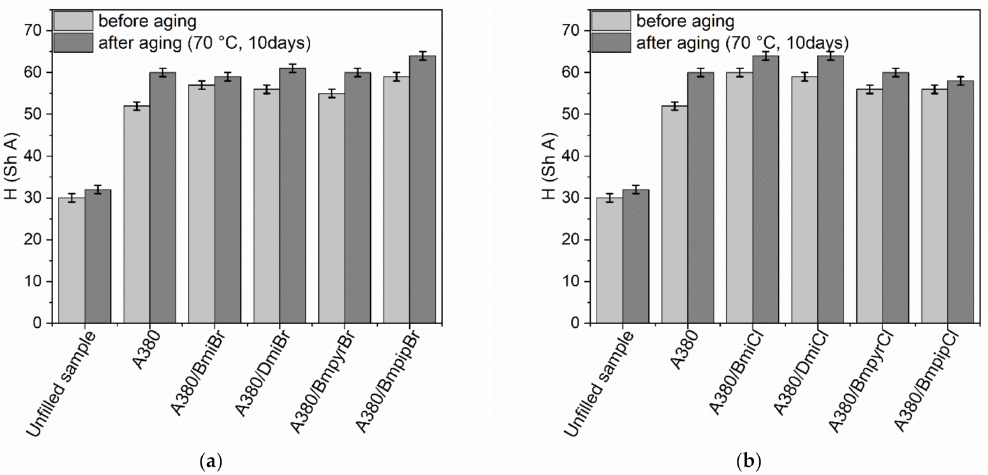
Figure 8. Influence of thermo-oxidative aging on the hardness of the silica-filled NR vulcanizates containing ILs with: ( a ) bromide anion; ( b ) chloride